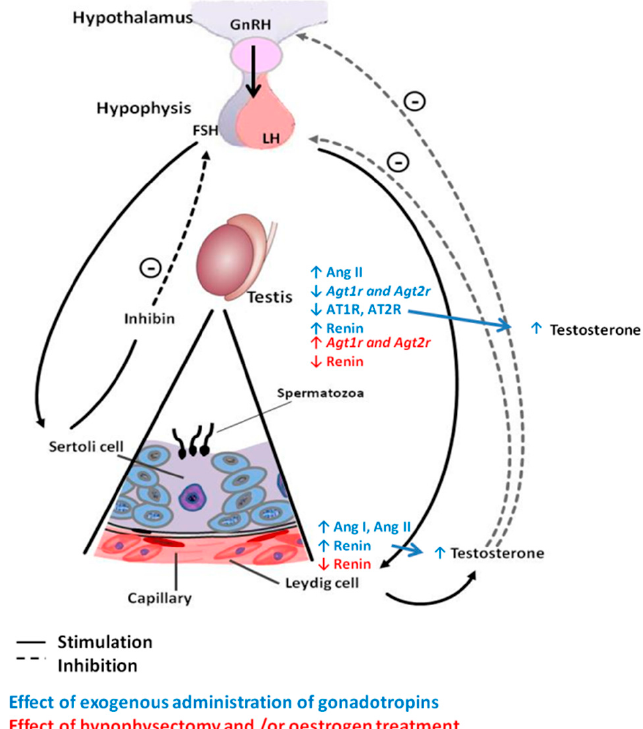
Figure 2. Endocrine regulation of the testicular RAS. At the testicular level, after gonadotropin stimulation, the levels of Ang II and renin increase, while the expression of the genes encoding both Ang II receptors as well as the levels of the receptors decrease. On the other hand, after hypophysectomy, the levels of renin decrease, but the mRNA expression of AT1R and AT2R increases. At the cellular level, in Leydig cells, exogenous administration of gonadotropins increases the levels of Ang I and II and renin, whereas oestrogen treatment or hypophysectomy decreases renin levels.